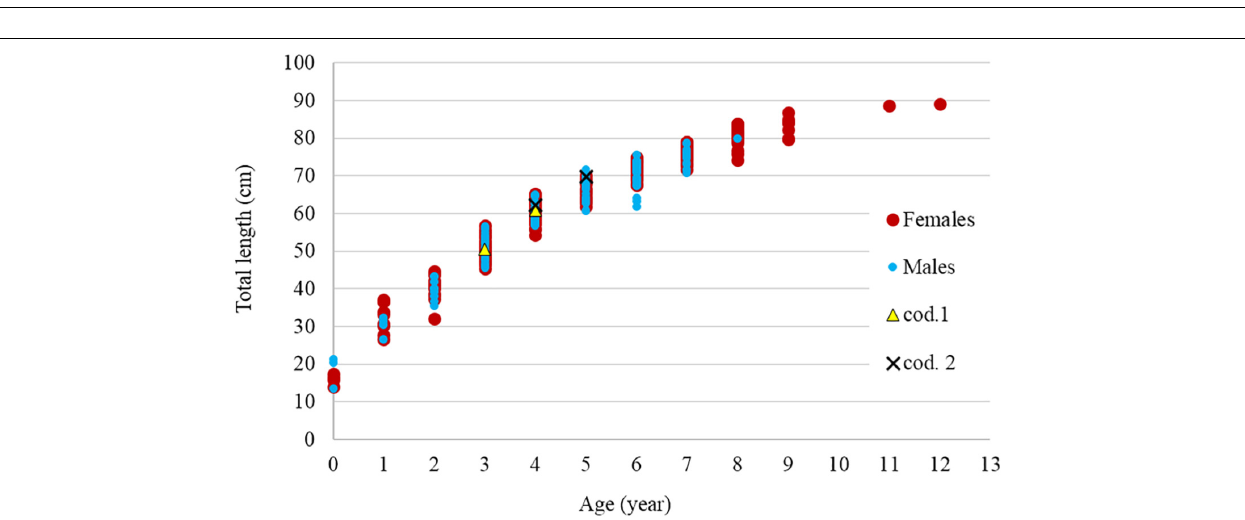
FIGURE 4 | Length frequency distribution of the R. clavata specimens by sex, used for the age analysis.